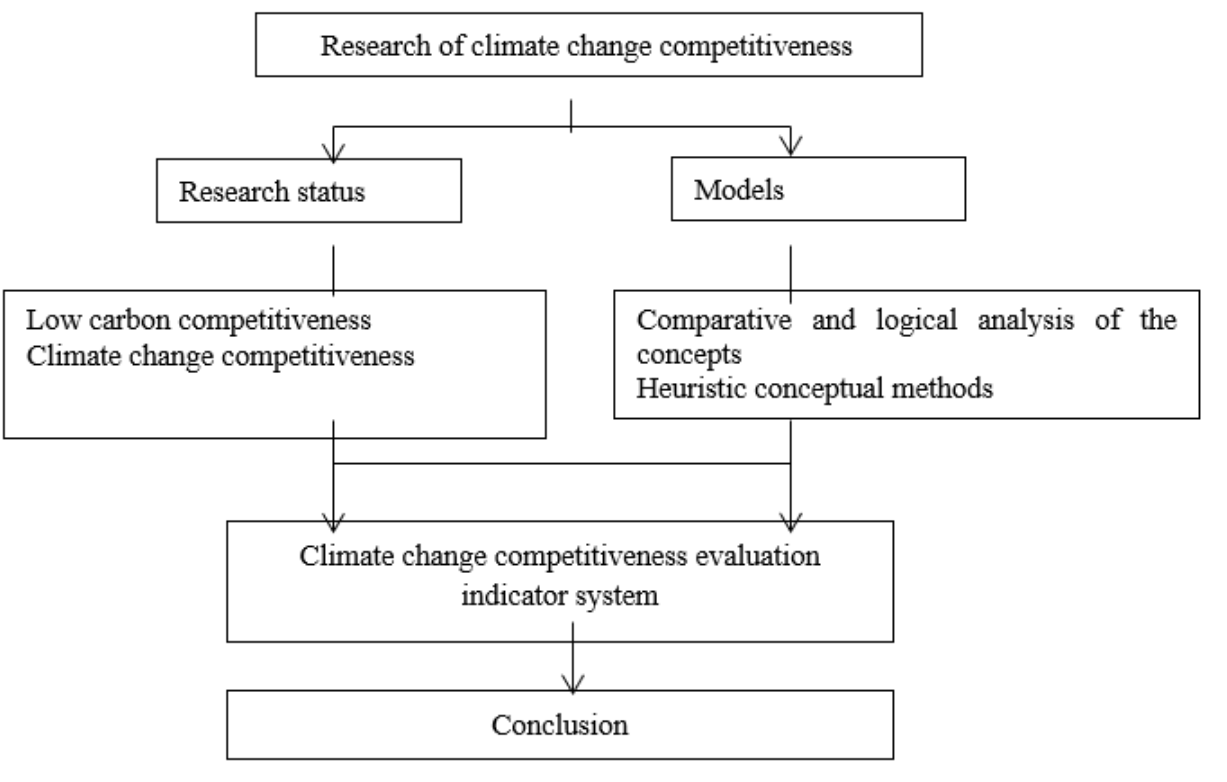
Figure 1. Research Figure 1. Research framework.